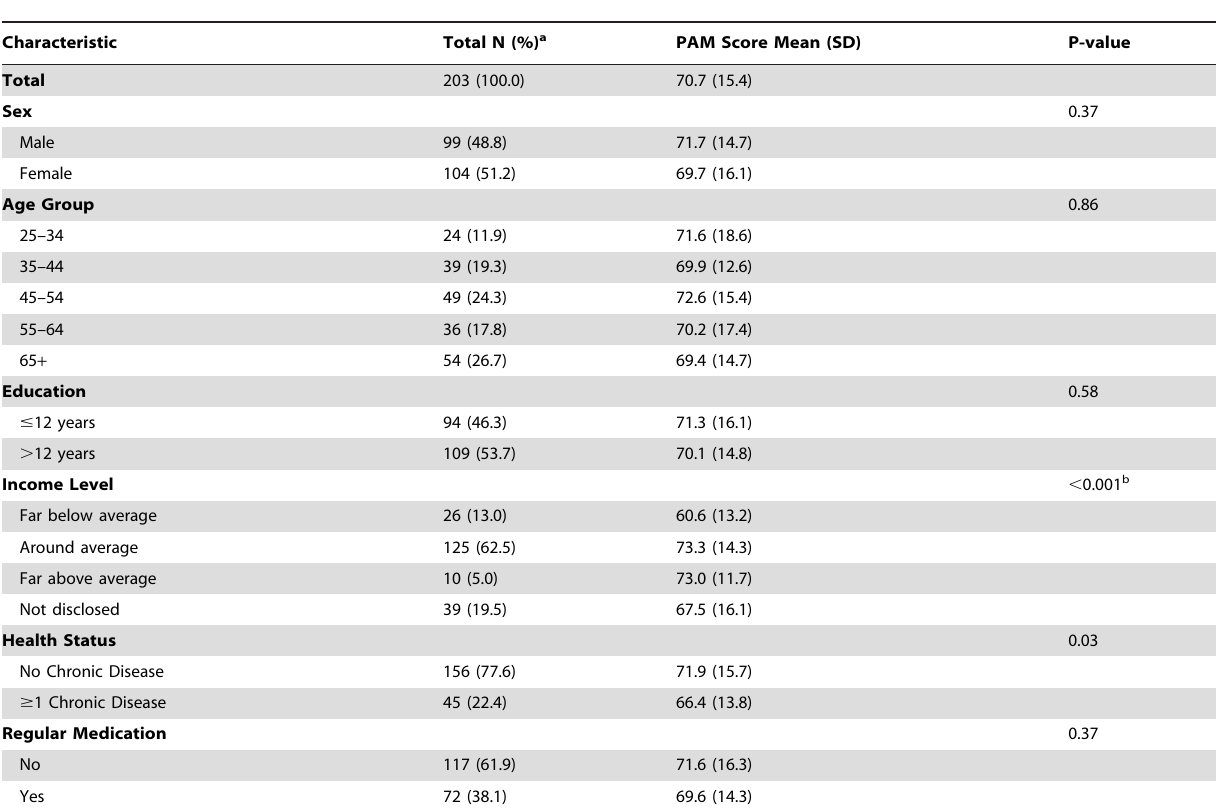
Table 1. Mean PAM scores by demographic and health